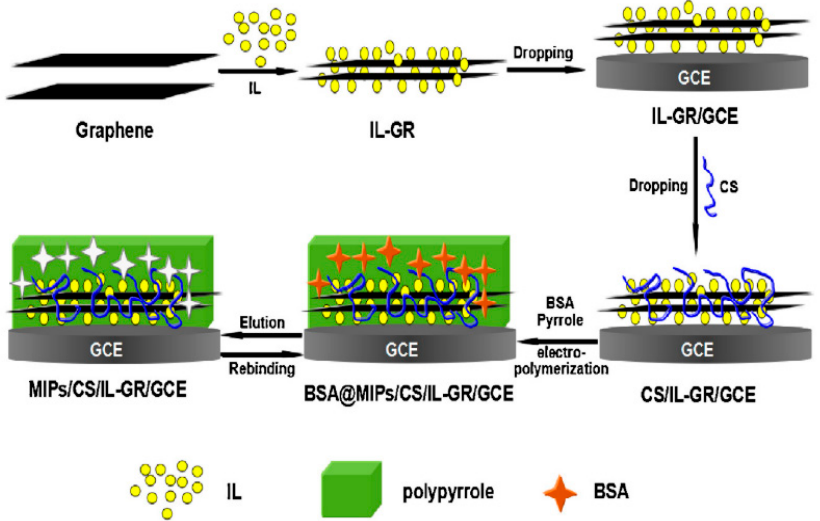
Figure 11. Schematic diagram of the preparation procedure of the molecular imprinted electrochemical sensor. Adapted with permission from reference [43]. Copyright © 2015 Elsevier.